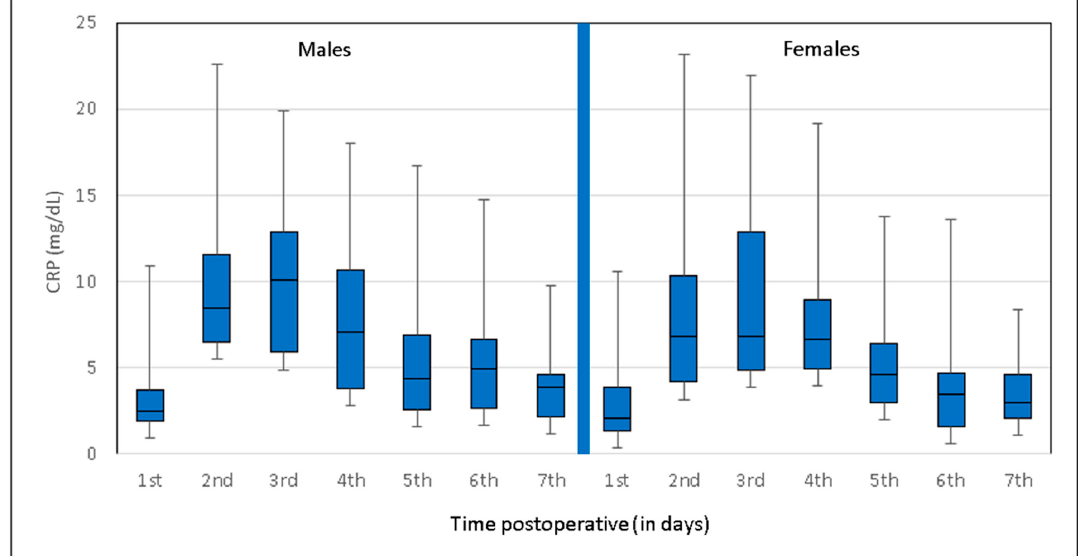
Figure 4. Box-and-whisker plot showing sex-specific C-reactive protein levels and trends following shoulder arthroplasty. Left: Males, right: Females. The blue boxes show the interquartile range (IQR). IQR is the span of the first and third quartiles and is therefore only slightly influenced by outliers. As the IQR refers to the first to third quartiles, a total of 50% of the data are herewith included.